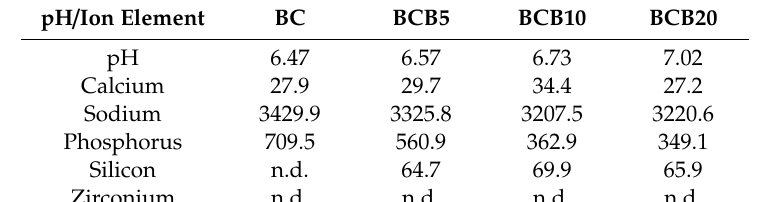
Table 3. pH and ion content of culture media conditioned with BC, BCB5, BCB10, and BCB20. All ion concentration measurements in parts per million (ppm). n.d.: not detectable.